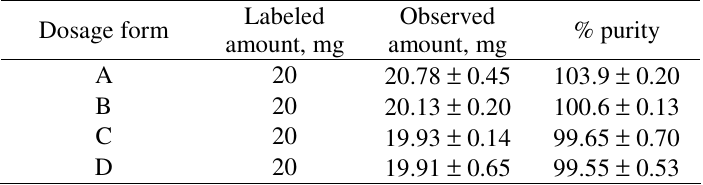
Table 4. Mean amount of RBP in tablet dosage forms by proposed